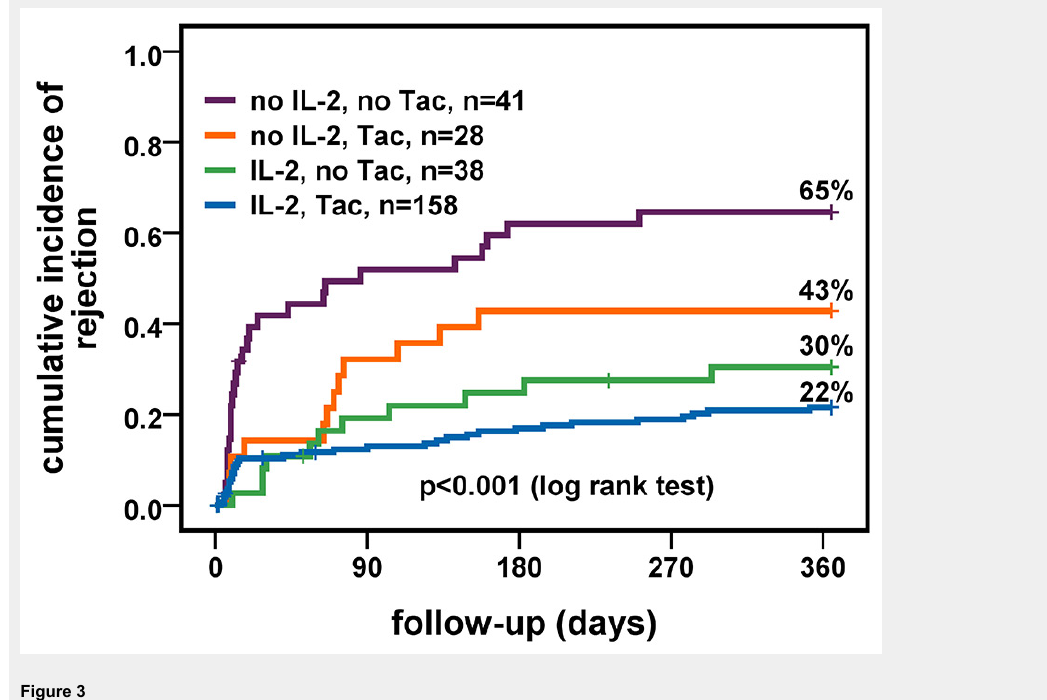
Figure 3 Cumulative incidence of clinical rejection stratified by immunosuppression and induction therapy. IL-2 = interleukin-2 receptor antagonist; Tac = tacrolimus